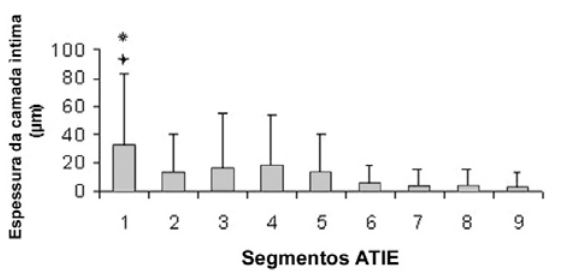
Fig. 5 - A espessura da camada média diminui ao longo de sua extensão proximal para distal Diferente do seg. 9;